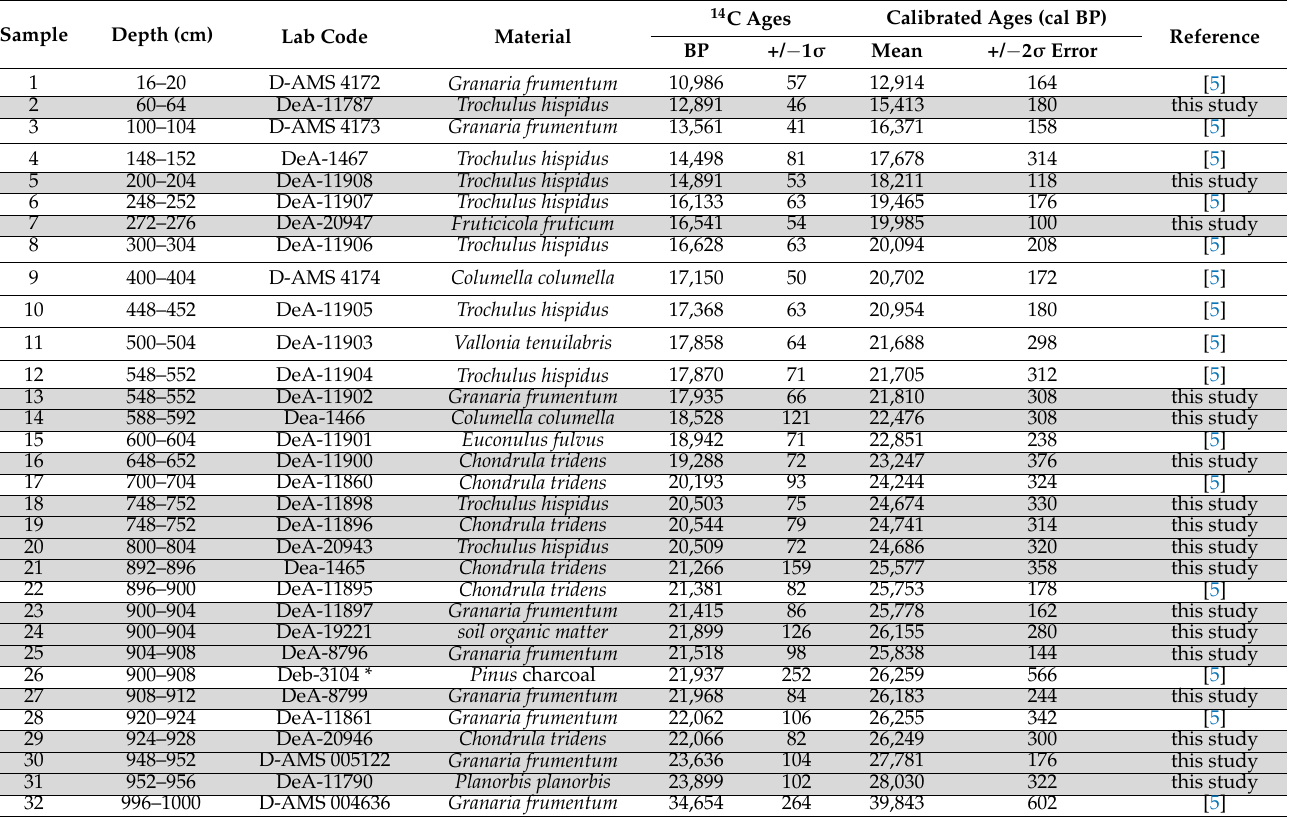
Table 1. List of samples with conventional and calibrated 14 C dates with new unpublished data